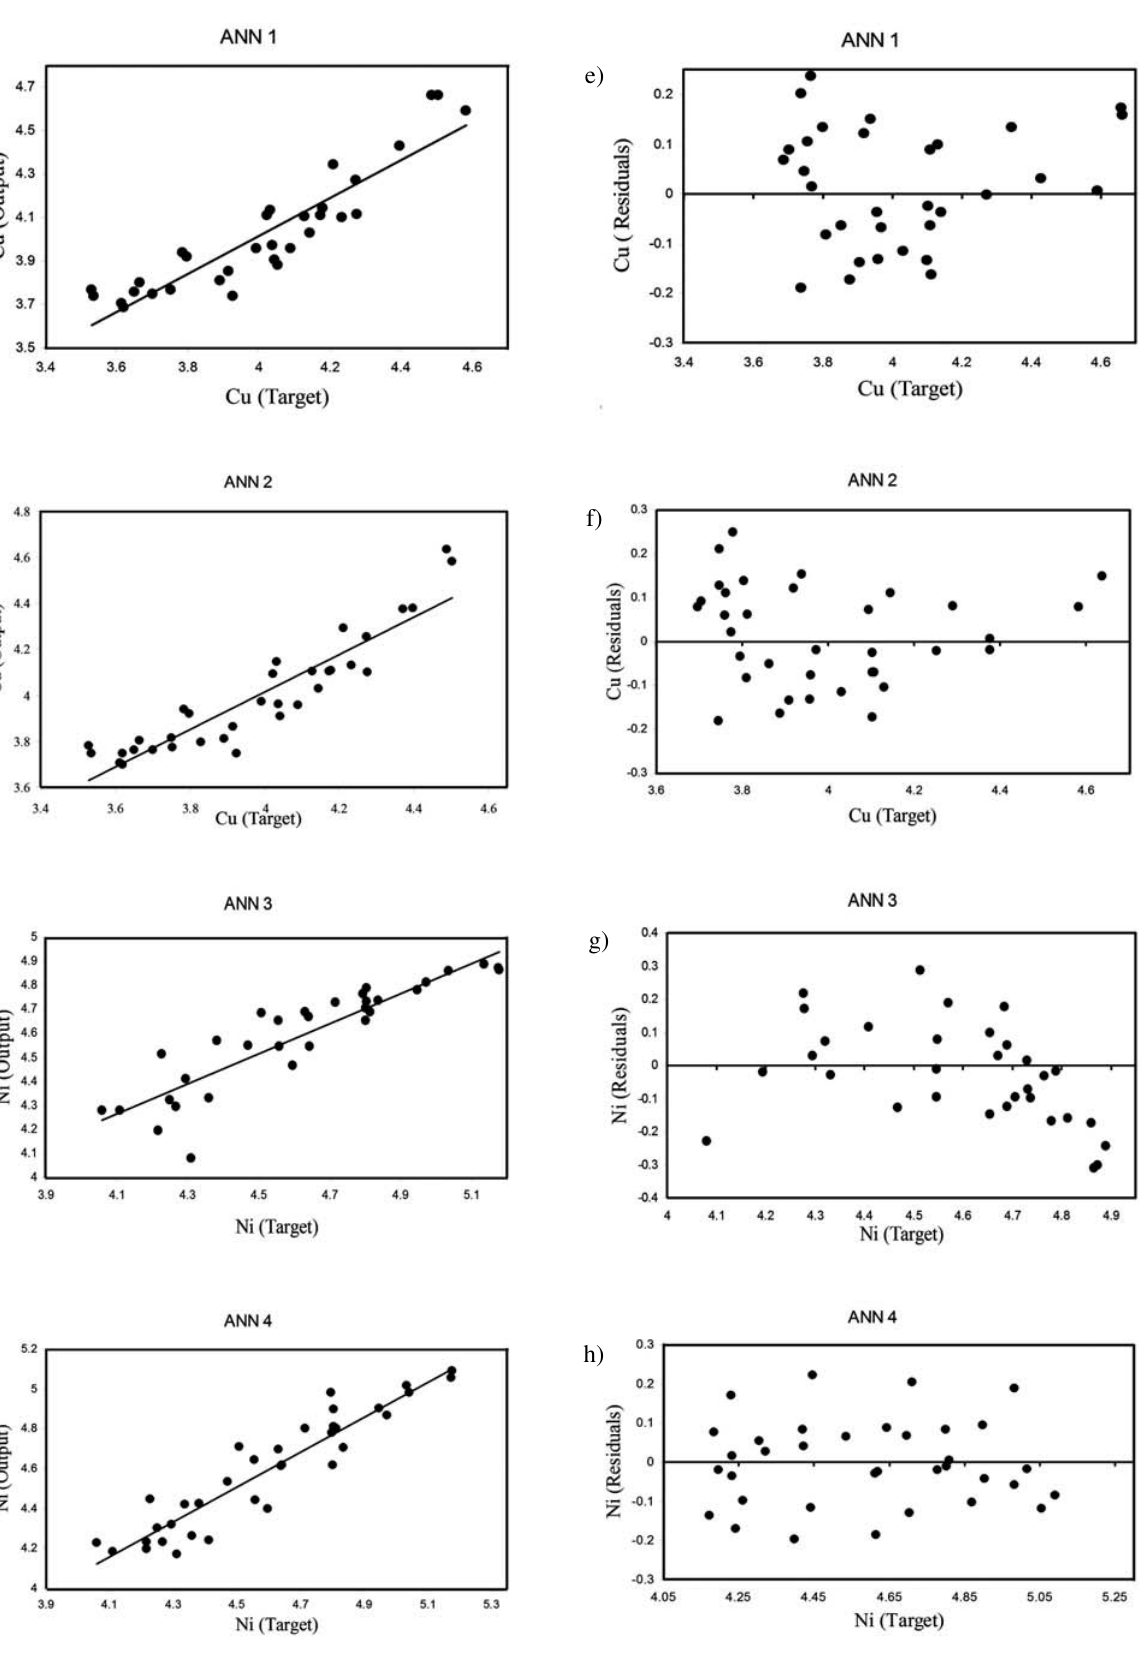
Figure 1. Comparison between measured and predicted values (a-d) and predicted and residual values (e-h) for ANN